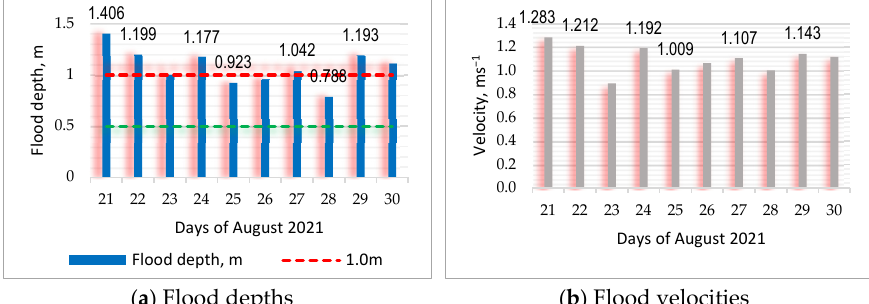
Figure 10. Plots of ( a ) flood depths and ( b ) velocities at an arbitrary grid cell.